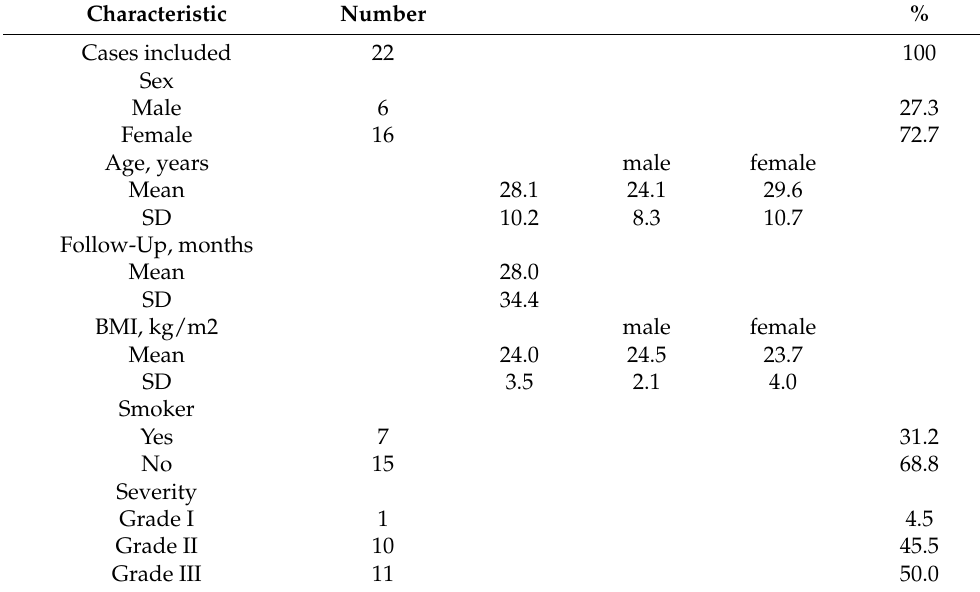
Table 2. Patient